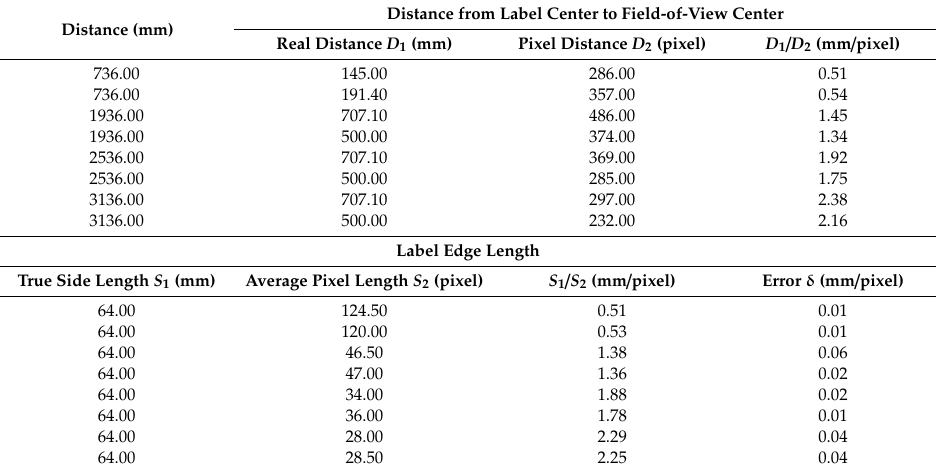
Table 4. Distance test results of image label (64 mm × 64 mm).